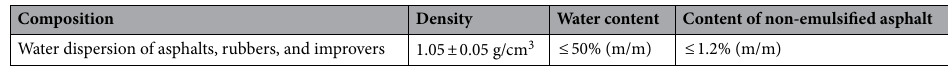
Table 4. Technical data of the commercial water-soluble